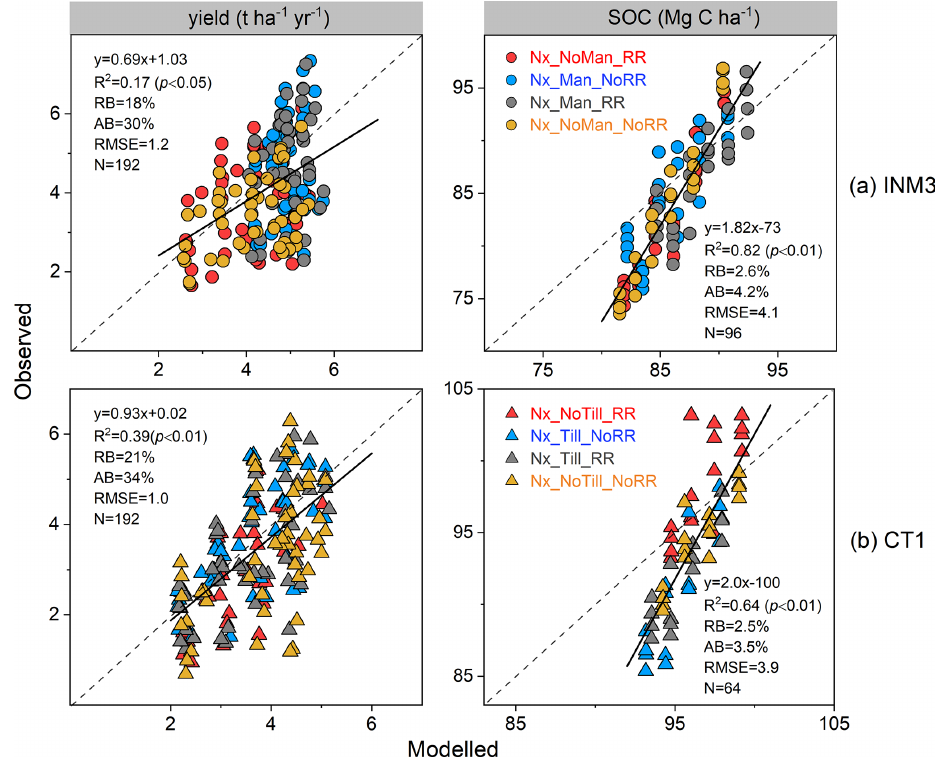
Figure 1. Comparison of modelled and observed maize yields (long rainy season, i.e., the main growing period) and SOC stocks at INM3 (a) and CT1 (b) sites for all treatments listed in Table 2. The dashed line is the 1 : 1 line, and the black bold line is the fitted linear regression; RB and AB are relative bias (Eq. 5) and absolute bias (Eq. 6), respectively, represented in percent (%); RMSE is root mean square error, with the unit of tha − 1 yr − 1 for yield and MgCha − 1 for SOC. See Table 2 for the treatment abbreviations and their